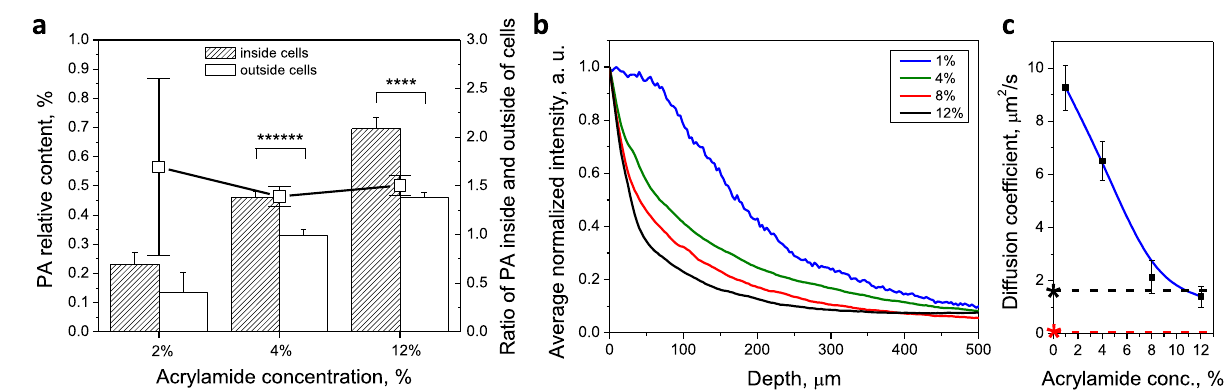
Figure 6. ( a ) Polymer relative content inside (hashed bars) and outside (hollow bars) cells as a function of acrylamide monomer concentration. Black line with square dots shows the ratio of polymer content inside to outside (3, 6, 5 cells analyzed for 2, 4 and 12% AAm conditions, respectively), ( b ) diffusion of F(Ab) ′ 2 over section depth after 1 h—integrated intensity across vertical sections of confocal images, ( c ) diffusion coefficient (μm 2 s −1 ) of F(ab) ′ 2 fluorescent secondary antibodies as a function of increasing AAm concentration (n = 4 across 2 animals). Diffusion coefficients for un-cleared and cleared PFA-only-fixed brain tissues are marked by red and black asterisks, respectively. Dashed lines are guides for the eye. Error bars mark means ± SD. Statistical significance marked as follows: **(p < 0.01), as measured by 2-sided non-parametric Mann–Whitney expected in the CLARITY brain data. The 0% sample tissue was uncleared to retain structural integrity and the fitting was performed with fat signal used as an additional MLR component to improve fit quality. Interestingly, the maps of 2%, 4% and 12% samples are not homogeneous and consistently reveal stronger polymer signal at locations corresponding to cell positions in the fluorescence maps. Polymer relative content was calculated by using content values from averaging 10 points inside and 10 points outside of cells (Fig. 6a). The ratio of polymer inside cell region to outside cell region remains relatively consistent for different initial AAm concentrations, and is approximately 1.5, suggesting there is 50% more polymer inside